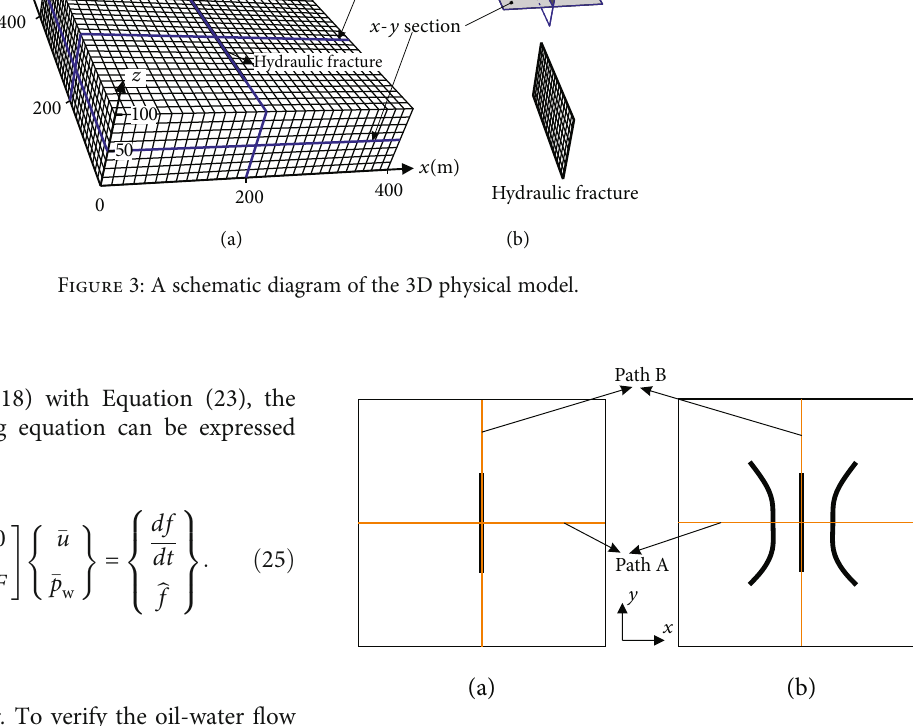
Figure 4: A schematic diagram of the hydrofracture layout ((a) presents the planar single fracture, and (b) presents the nonplanar multiple